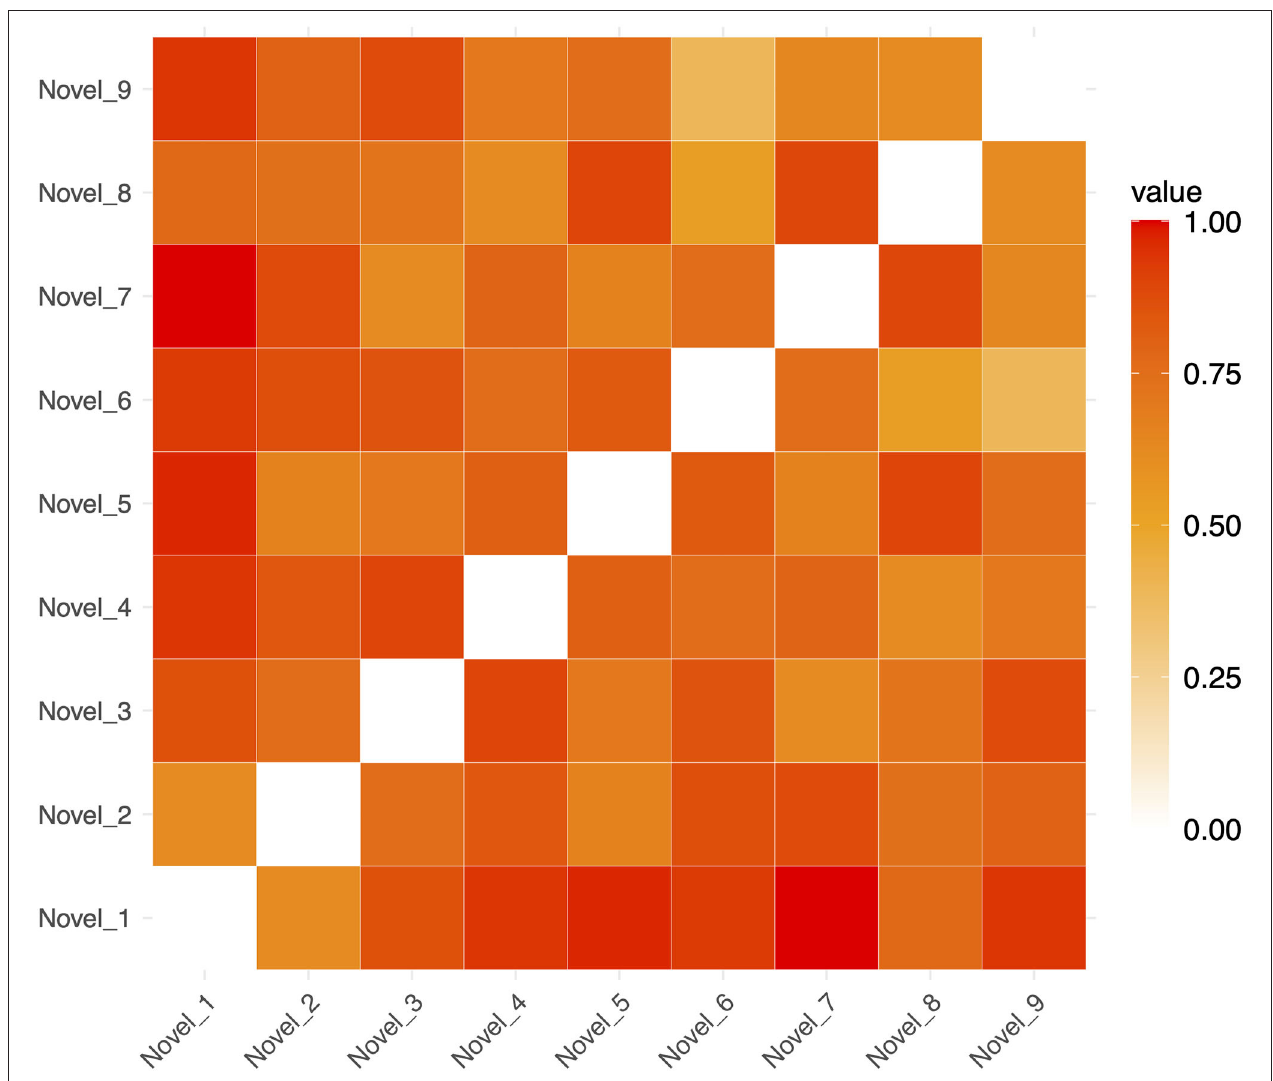
FIGURE 4 | Example Representational Dissimilarity Matrix for novel sequences in a single run (for ease of visualization). The dissimilarity between any pair of sequences is indicated by the color of in the cells of the